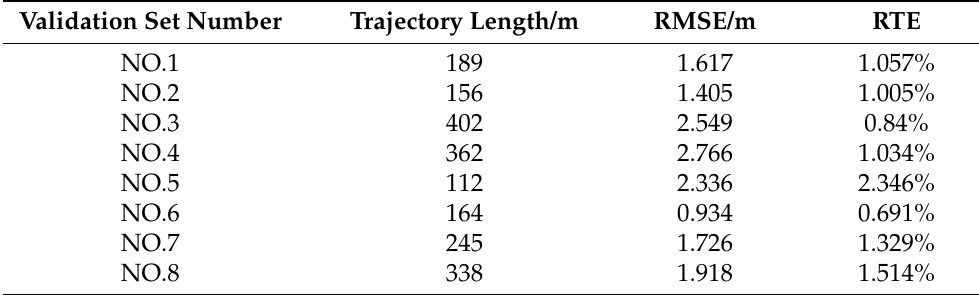
Table 1. Evaluation metrics of the validation set on the model. Validation Set